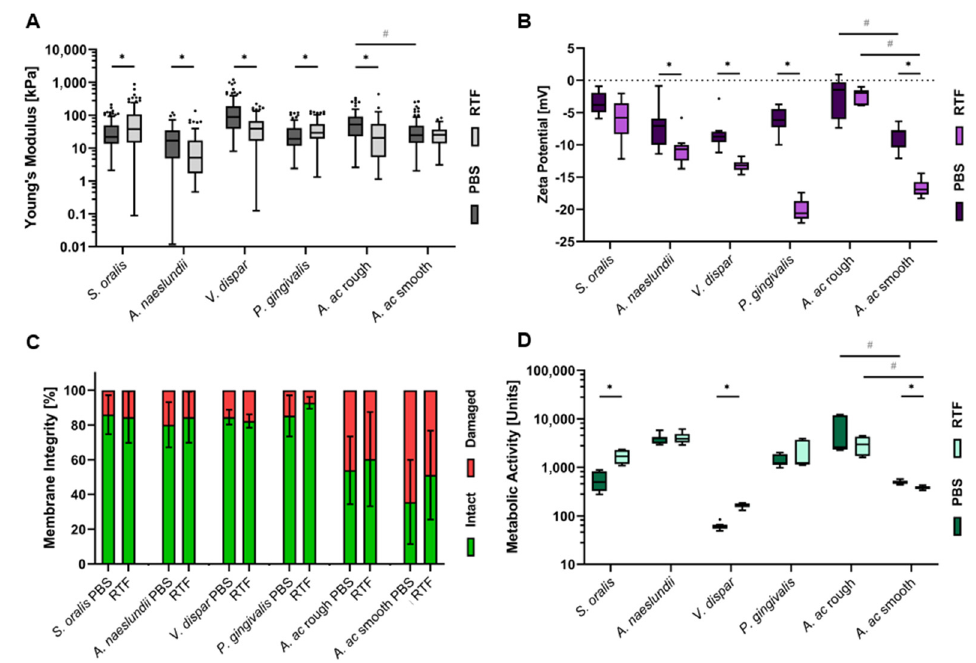
Figure 4. Cellular characteristics of oral bacteria in different buffers. ( A ) Tukey boxplots of bacterial Young’s moduli measured by SCFS with setpoint force of 0.75 nN, ( B ) Tukey box plots of bacterial zeta potential, ( C ) percentage in mean ± standard deviation of bacteria with intact and damaged membrane detected by fluorescence staining and CLSM of indicated strains after 5 h incubation and ( D ) Tukey boxplots of bacterial metabolic activity after 5 h incubation measured by ATP quantification of indicated strains in PBS and RTF buffer. * indicates statistically significant differences for each strain and # indicates statistically significant differences between rough and smooth A. ac in the corresponding buffer with p ≤ 0.05 according to Wilcoxon test ( A ), Mann–Whitney-U test ( A. naeslundii in ( B ), all strains in ( C )) and unpaired t-test (all other strains in ( B ), all strains in ( D )).